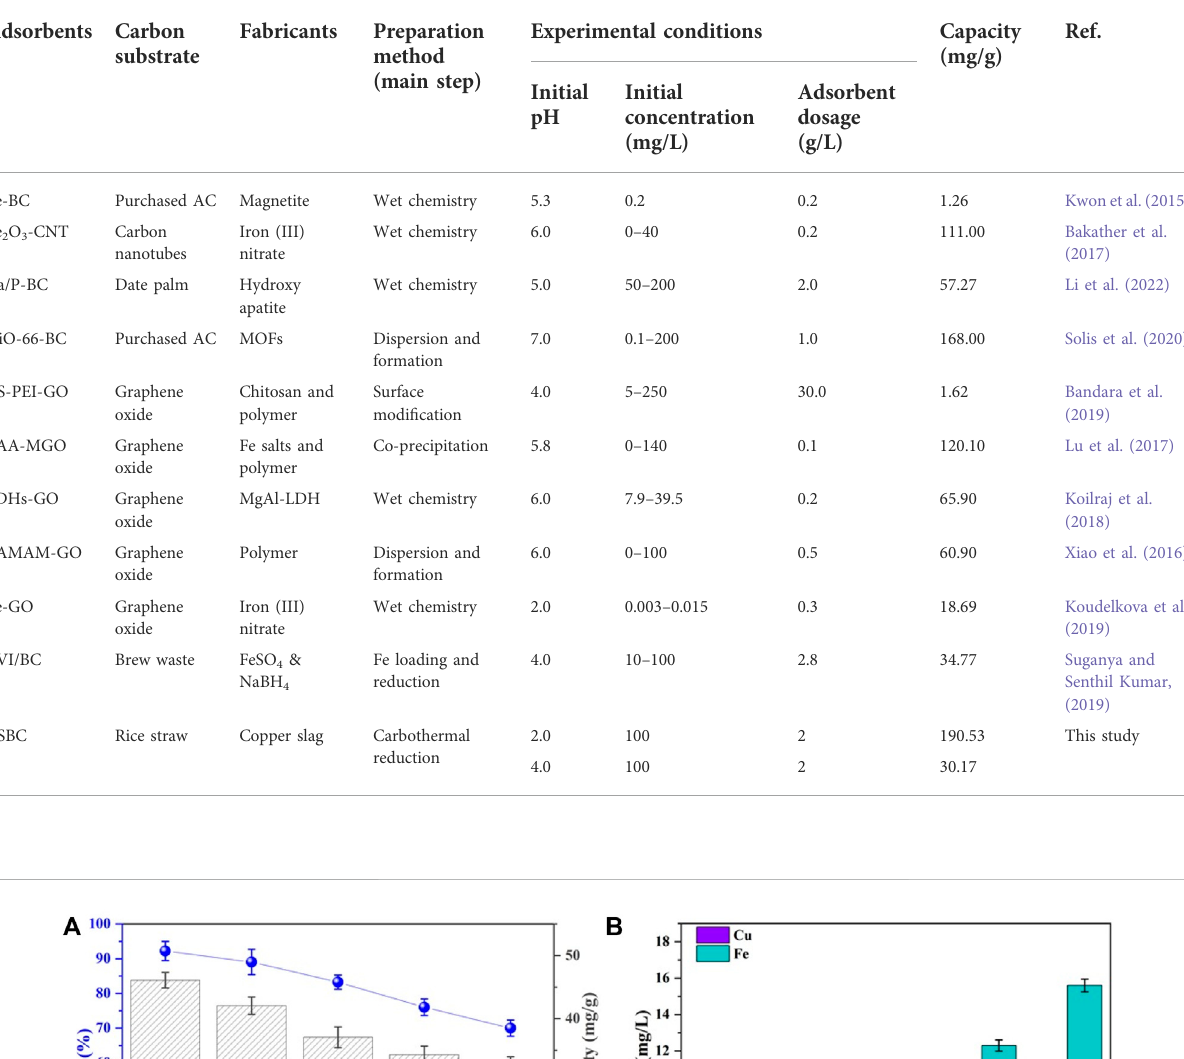
TABLE 4 Comparison of adsorbents for Se(IV) removal.